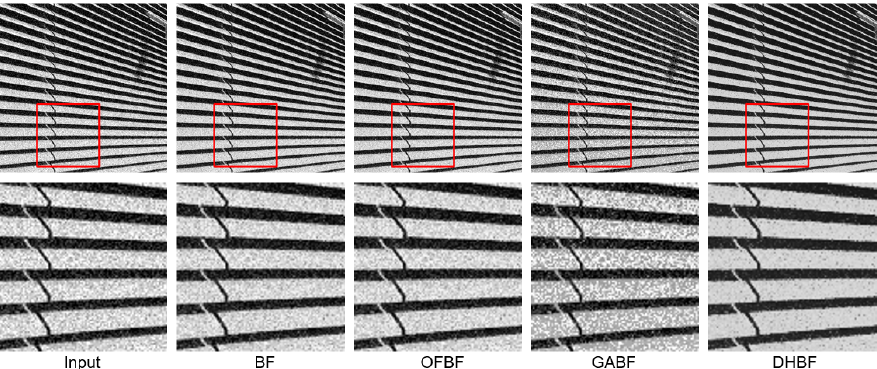
Figure 10. Visual comparison of the representative sample for image smoothing on